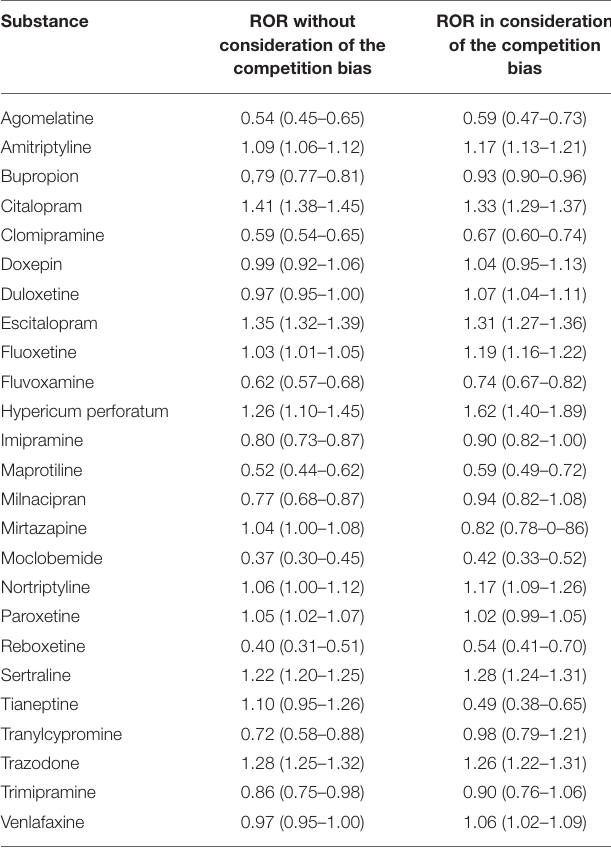
TABLE 1 | Reporting odds ratios and 95% CIs related to antidepressants and the SMQ “haemorrhage” with and without consideration of the competition